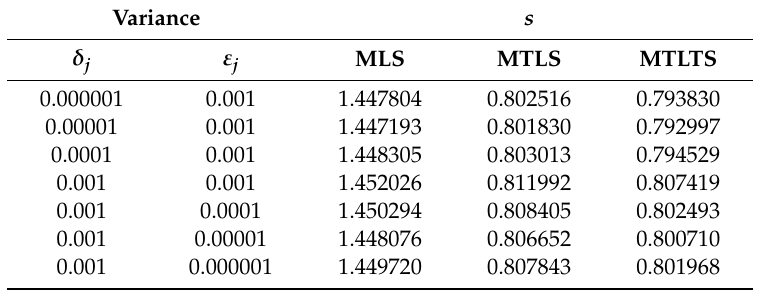
Figure 5. The fitting and error surfaces of three methods in Case 2. ( a1 ) The fitting surface of MLS;